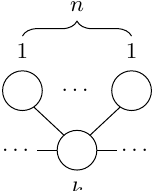
Figure 36 . Local part of a quiver with a n (cid:13)avor node attached to a k gauge node.